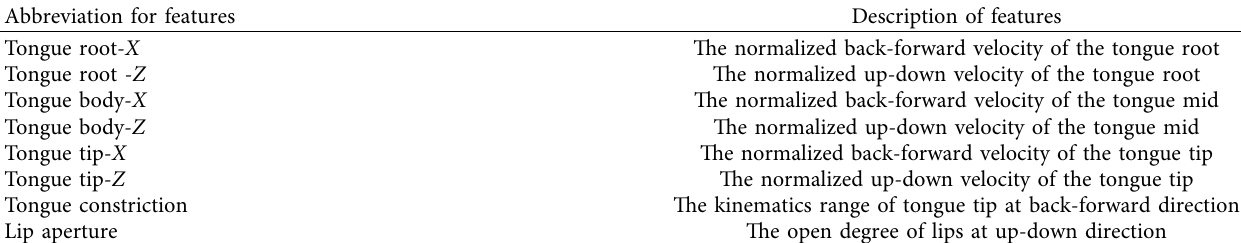
Table 1: Articulatory features.